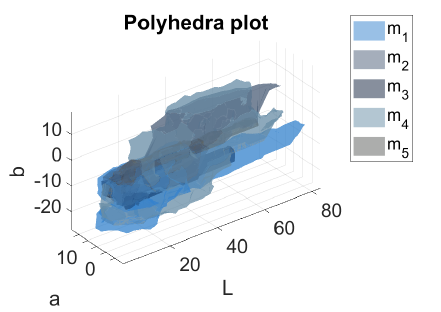
Figure 8. 3D plot of the five polyhedra in the Lab color space defined in this work. Different sea colors are used to represent each